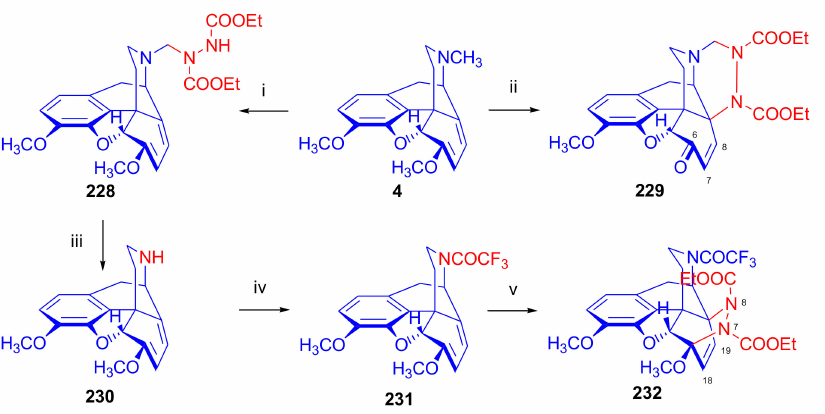
Figure 62. Reaction of thebaine and N 17 -trifluoroacetyl-northebaine with diethyl azodicarboxylate (DEAD). Reagents and conditions : (i): 1 equiv. DEAD, benzene, reflux, 16 h; (ii): (1) 2 equiv. DEAD, benzene, reflux, 2 h, (2) 2M HCl, Et 2 O, 1 h, 57%; (iii): saturated NH 4 Cl solution; (iv): trifluoroacetic anhydride, EtOAc, CHCl 3 , 25 ◦ C, 45 min, 83%; and (v): 1.5 equiv. DEAD, benzene, reflux, 12 h,